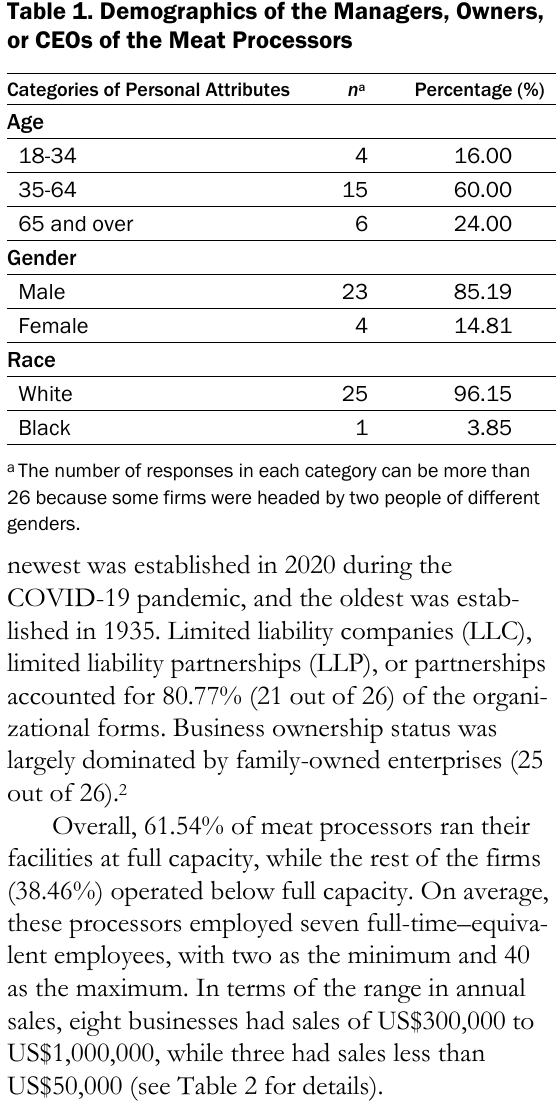
Table 1. Demographics of the Managers, Owners, Table 2. Business Characteristics of Small-